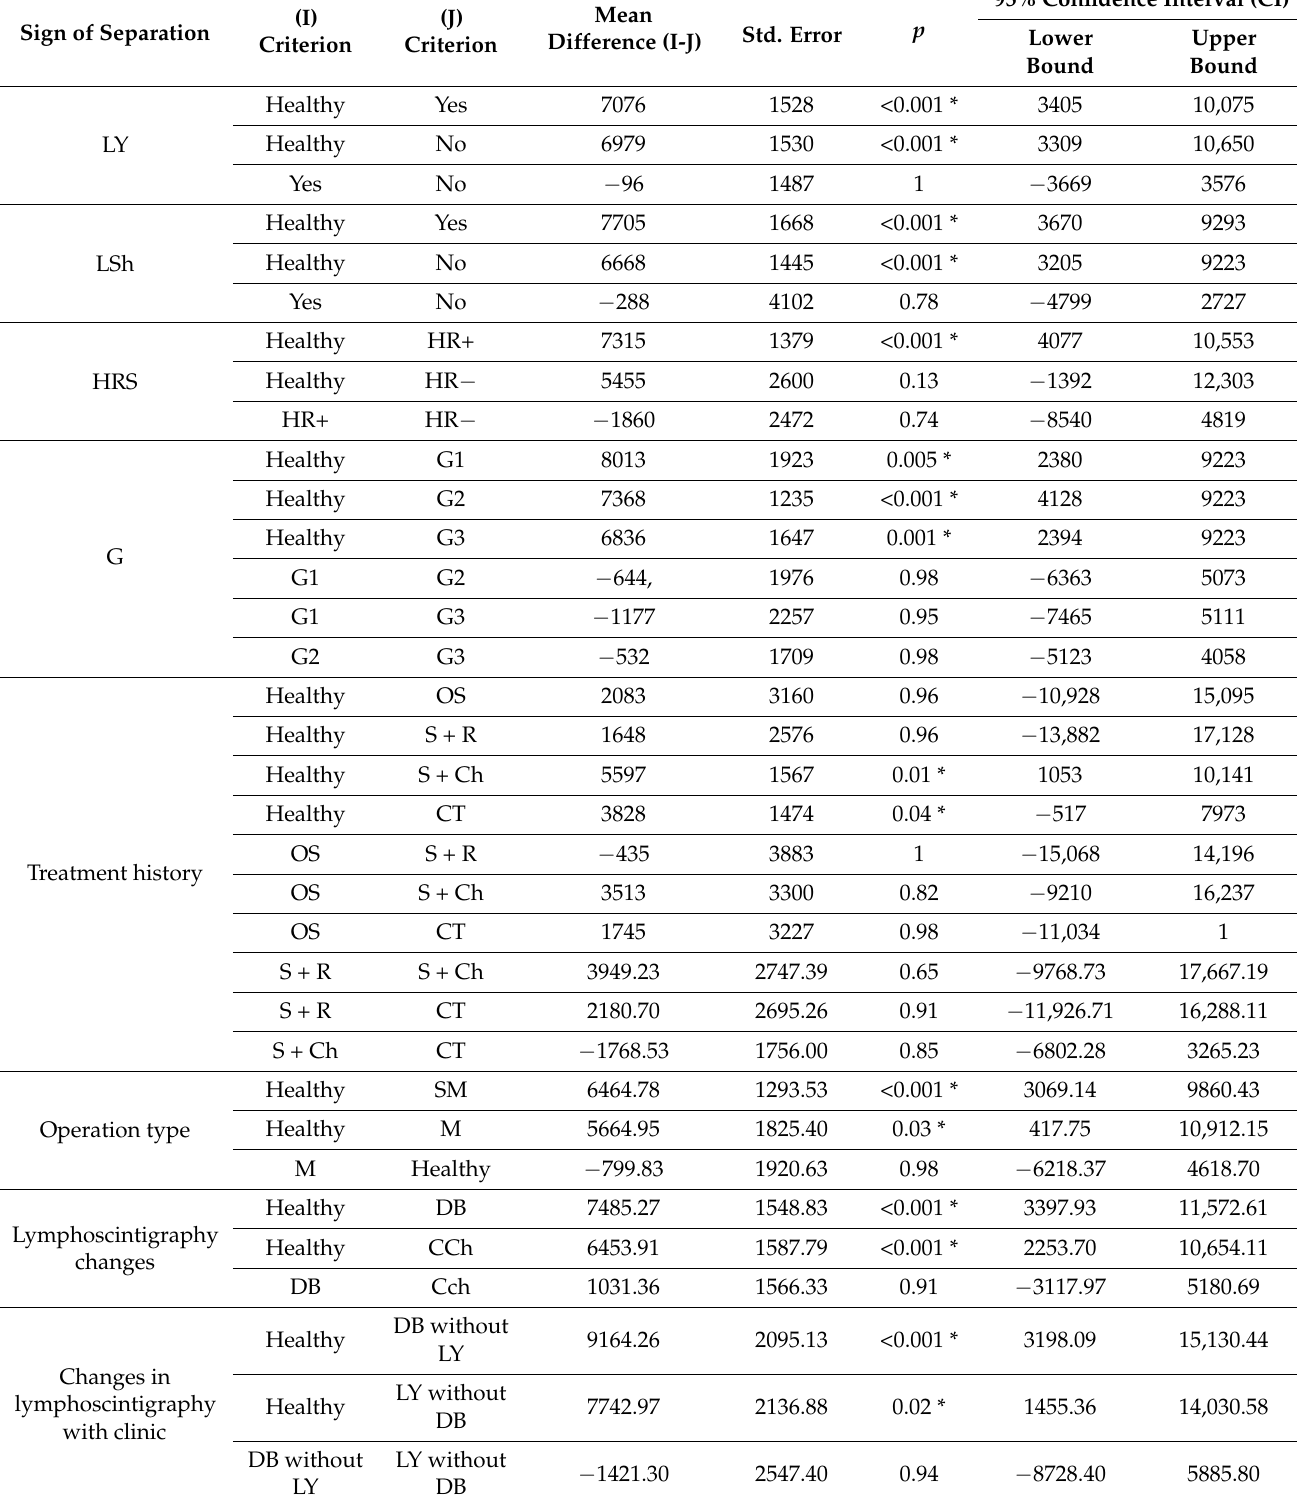
Table 6. Games–Howell test result for two groups according to TGF- β 1